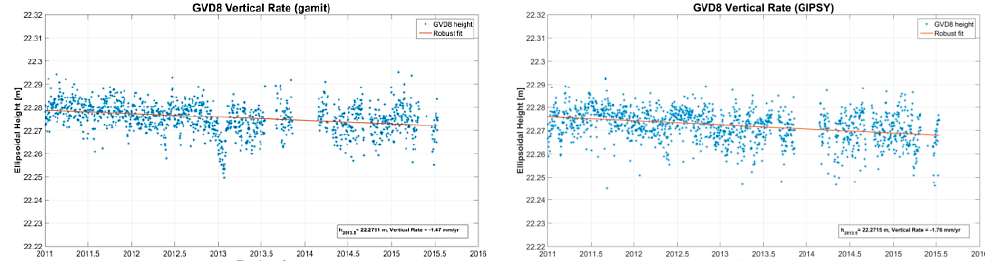
Figure 15. The GVD8 GNSS station height and vertical velocity as derived by GAMIT and GIPSY software processing. A difference of the order of ~0.3 [mm/yr] in the vertical rate estimation is observed over 4 years of measurements. over 4 years of